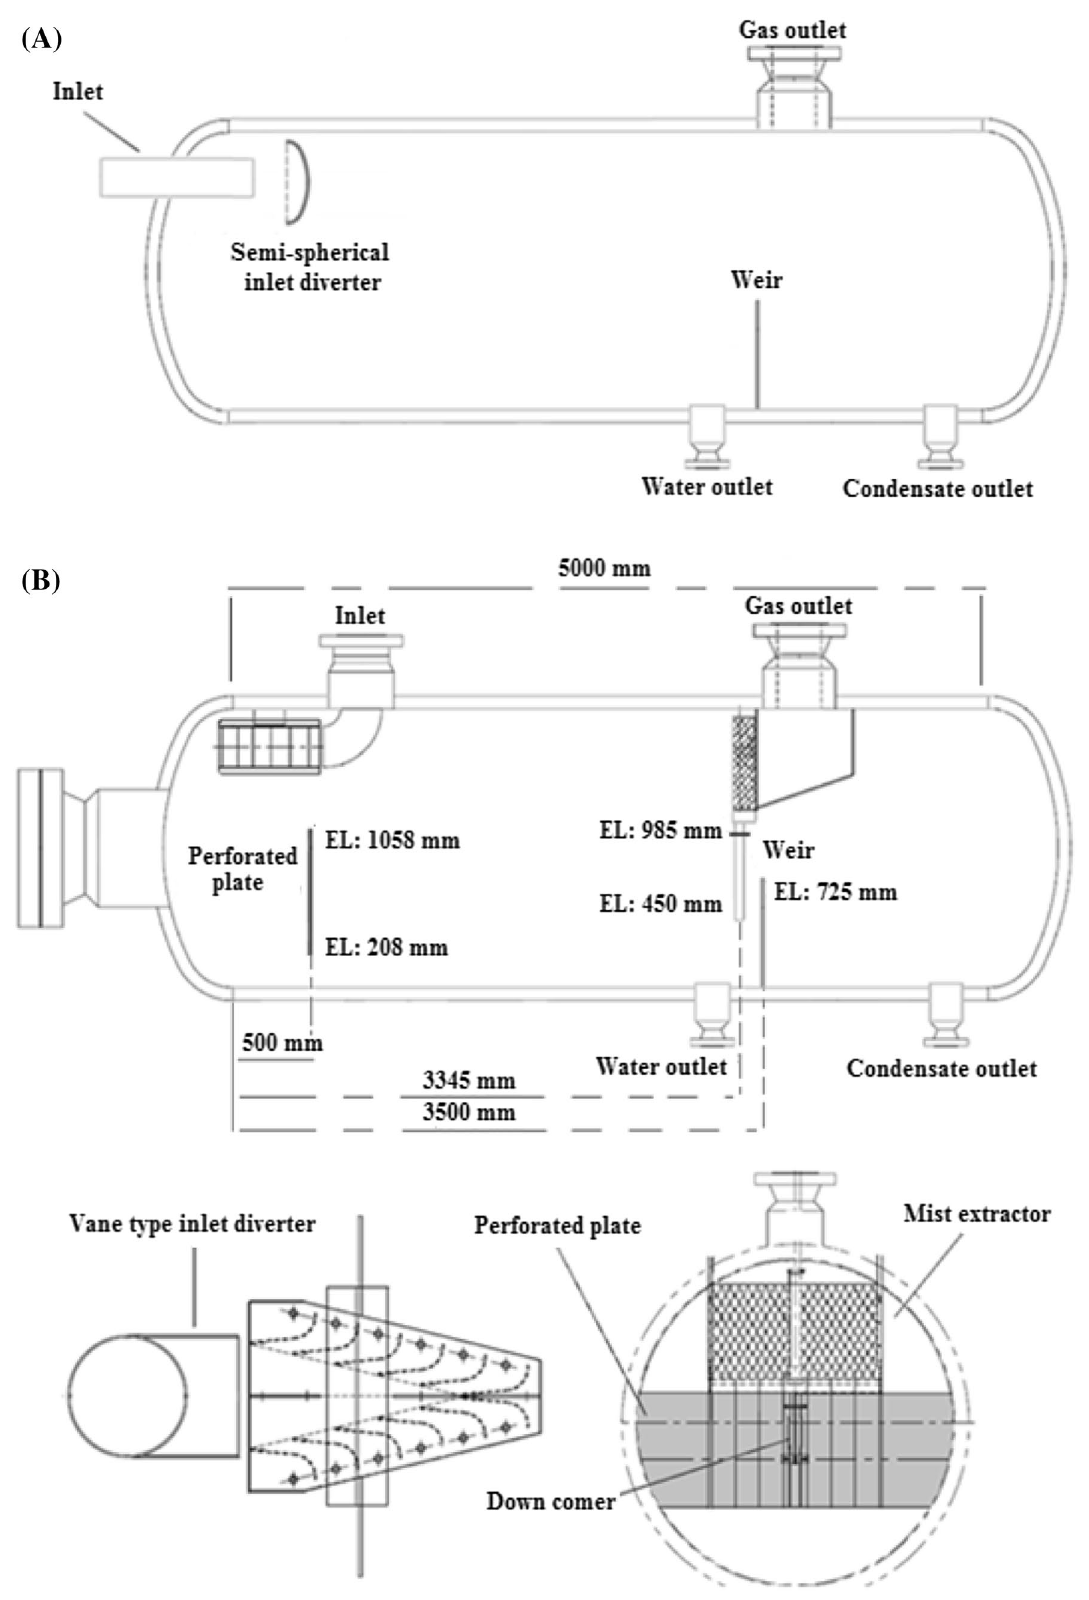
Fig. 1 Arrangement of the internals for Cases 1–5 ( a ) and Case 7 (validation case) ( b